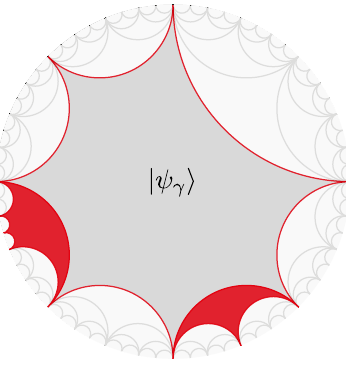
Figure 15 . Holographic state on bigger